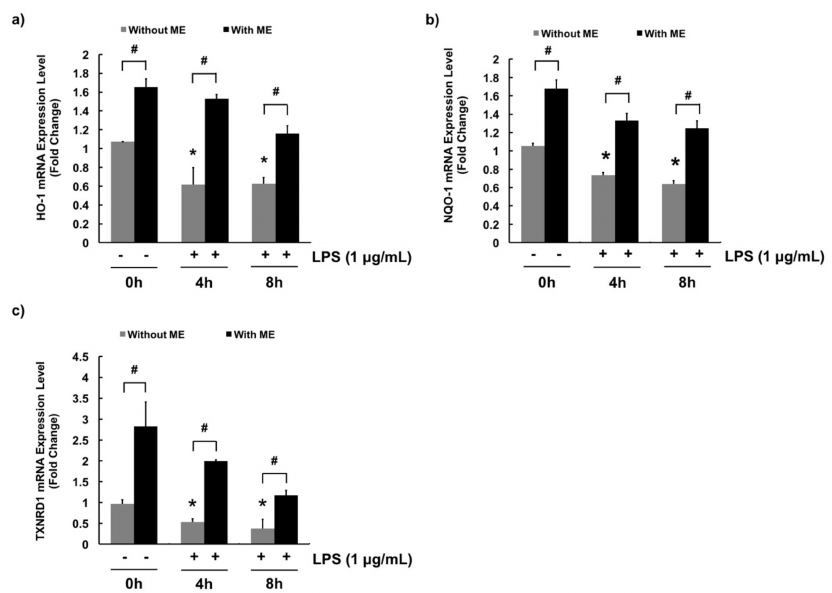
Figure 6. Moringa extract (ME) increases mRNA expression levels of anti-oxidant enzymes in MAC-T cells. mRNA expression levels of ( a ) HO-1, ( b ) NQO-1, and ( c ) TXNRD1 were determined. Cells were pre-treated with or without ME (200 µ g / mL) for 12 h followed by LPS treatment (1 µ g / mL) for 0, 4, and 8 h. mRNA expression levels were measured using RT-PCR. mRNA expression levels were calculated relative to GAPDH expression. Values represent means ± SEM ( n = 3). *, significant difference vs. control (No ME, no LPS) ( p < 0.05). #, significant difference between the two treatment groups ( p < 0.05).